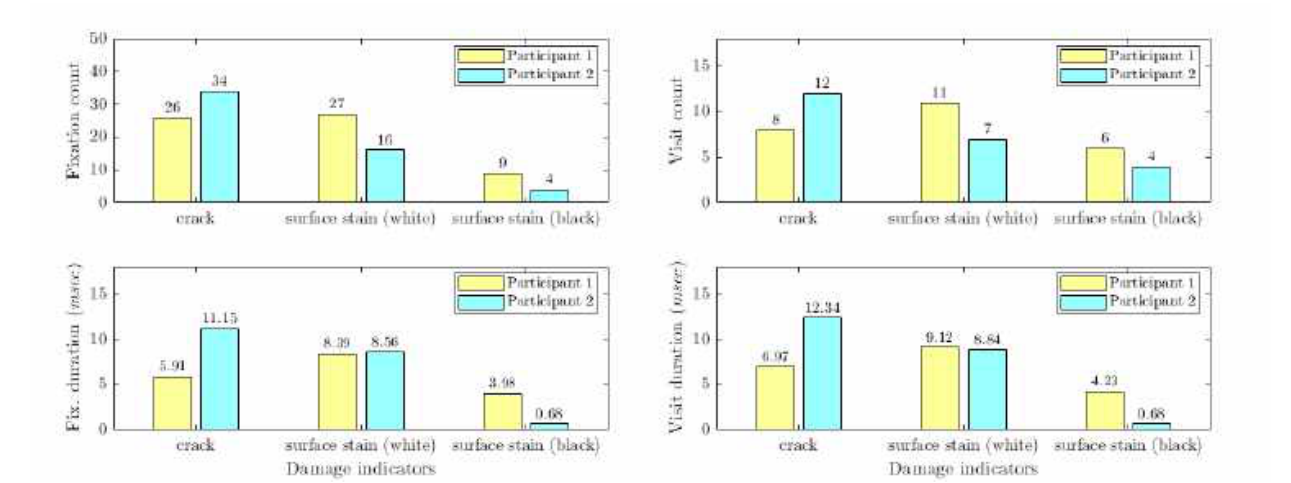
Figure 6. Comparison of fixation count Vs. total fixation duration per AOI